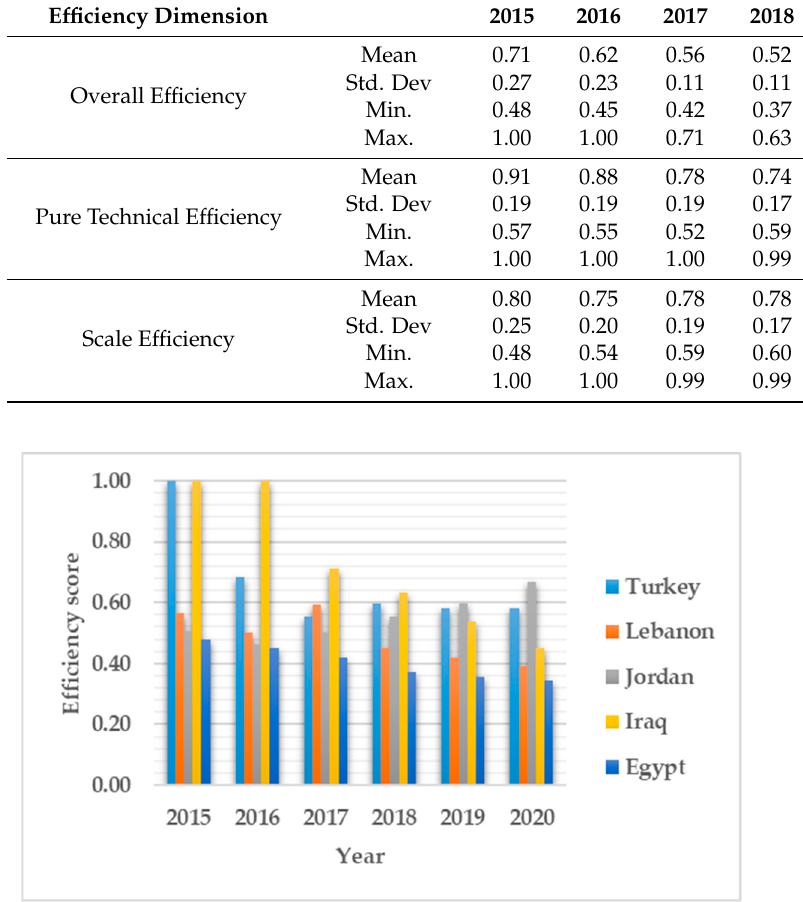
Figure 2. Overall efficiency scores.